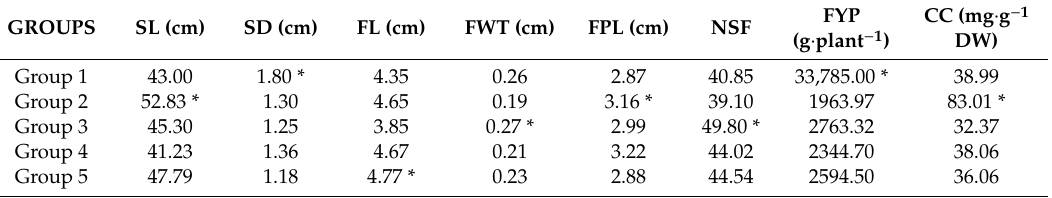
Figure 5. Dendrogram of the hierarchical cluster analysis showing the clusters of the 29 F1 lines and 11 progenitors habanero pepper based on the traits that made greater contributions to the PCA. Table 8. Mean values of the evaluated qualitative and quantitative traits for each of the groups established by cluster analysis.